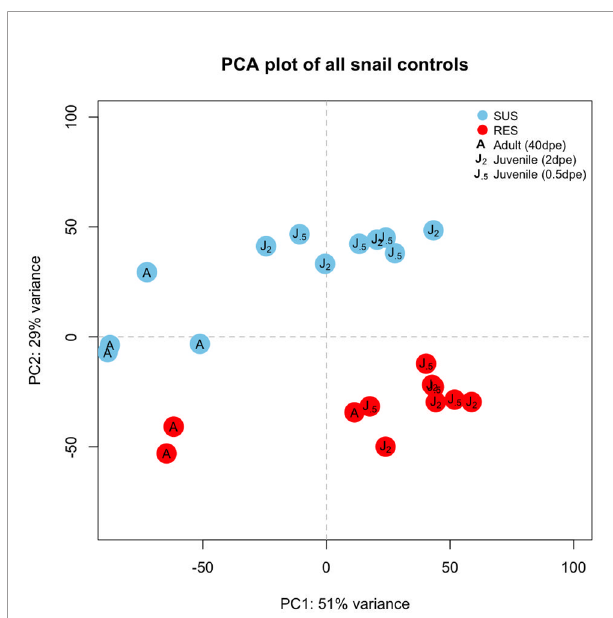
FIGURE 2 | Principal components analysis (PCA) plot indicating the six groups of unexposed control snails examined in this study. Results for SUS snails are shown in blue circles and red circles indicate RES snails. “ J .5 ” refers to juvenile control snails matched in size and time matched to snails exposed to S. mansoni for 0.5 days, “ J 2 ” refers to control juveniles matched to snails exposed to S. mansoni for 2 or 8 days, and “ A ” refers to adult snail size (time matched controls for snails exposed to Sm, 40 dpe).